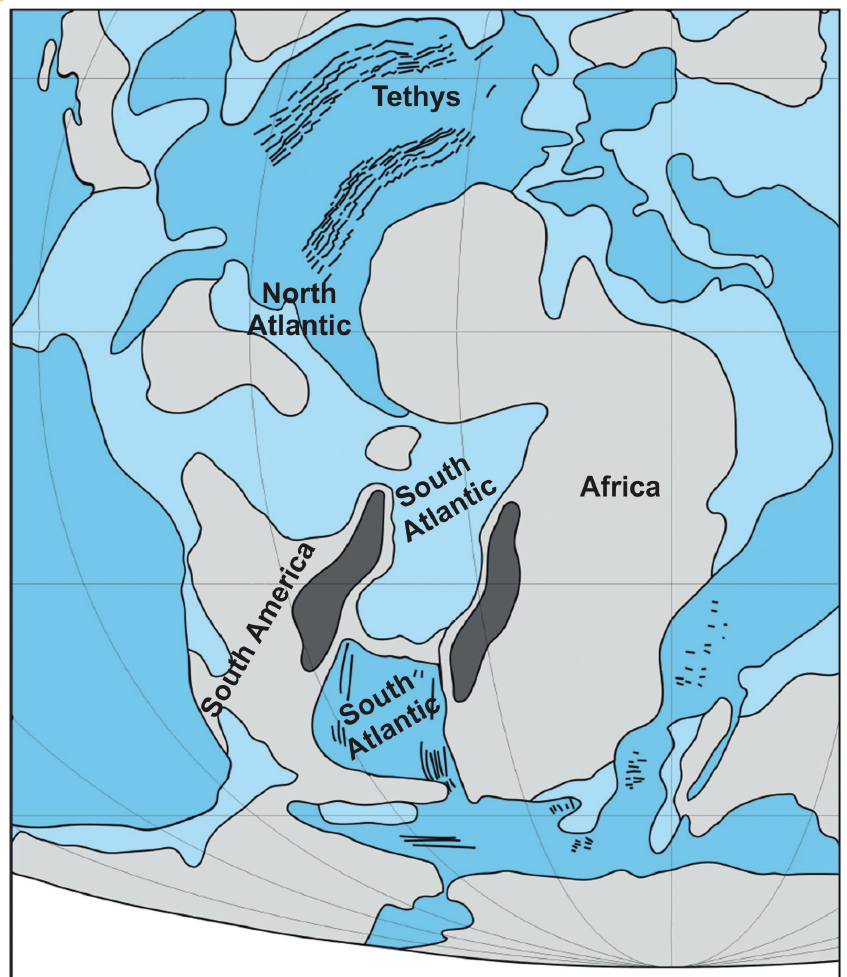
Figure 2 - Paleogeographic reconstruction of Atlantic Ocean in the Albian (modified from Azevedo